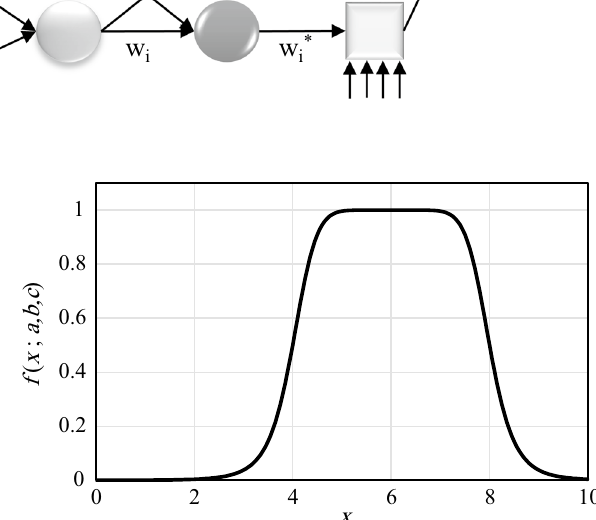
Fig. 6 Bell-shaped membership function ( a = 2, b = 4, c =